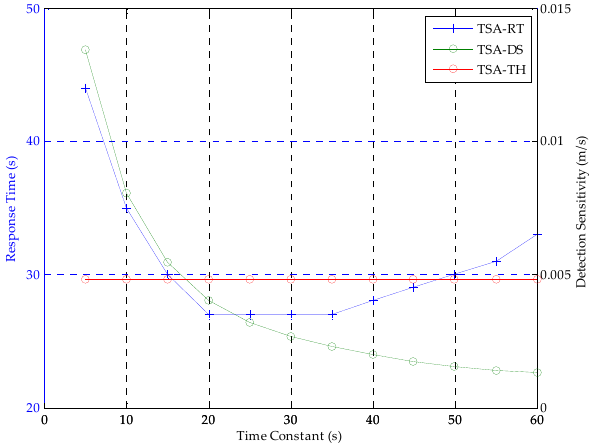
Figure 4. Relationship between time constant and response time to anomaly, detection sensitivity when n k ~ N (0, 0.25).